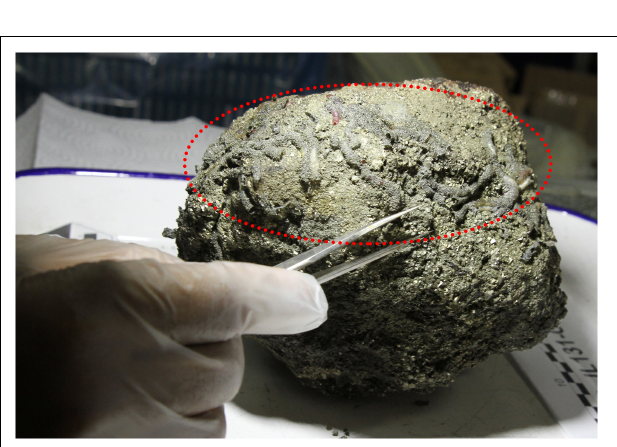
FIGURE 2 | A massive pyrite collected from Wocan field during Jiaolong Dive 131, covered by tubes of Paralvinella mira (circled by red dotted